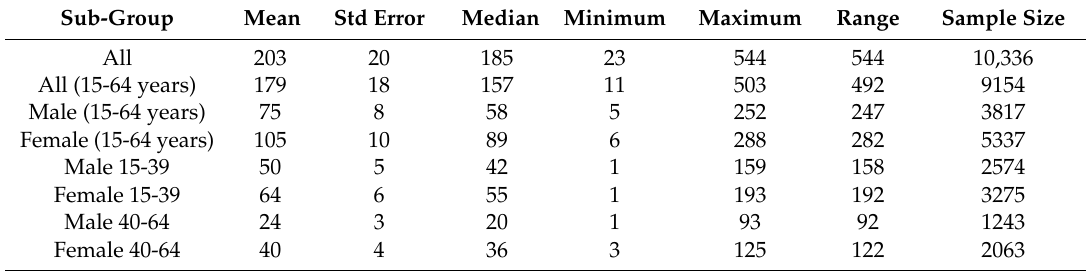
Table A1. E ff ects of stratification on the sample size used in the